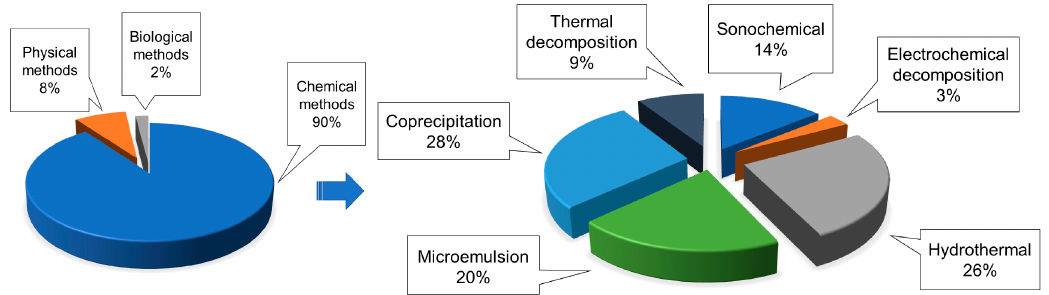
Figure 1. A comparison among the prevalence of the main methods currently existing for the synthesis of IONPs, with the detailed chemical methods prevalence. Modified from [14].